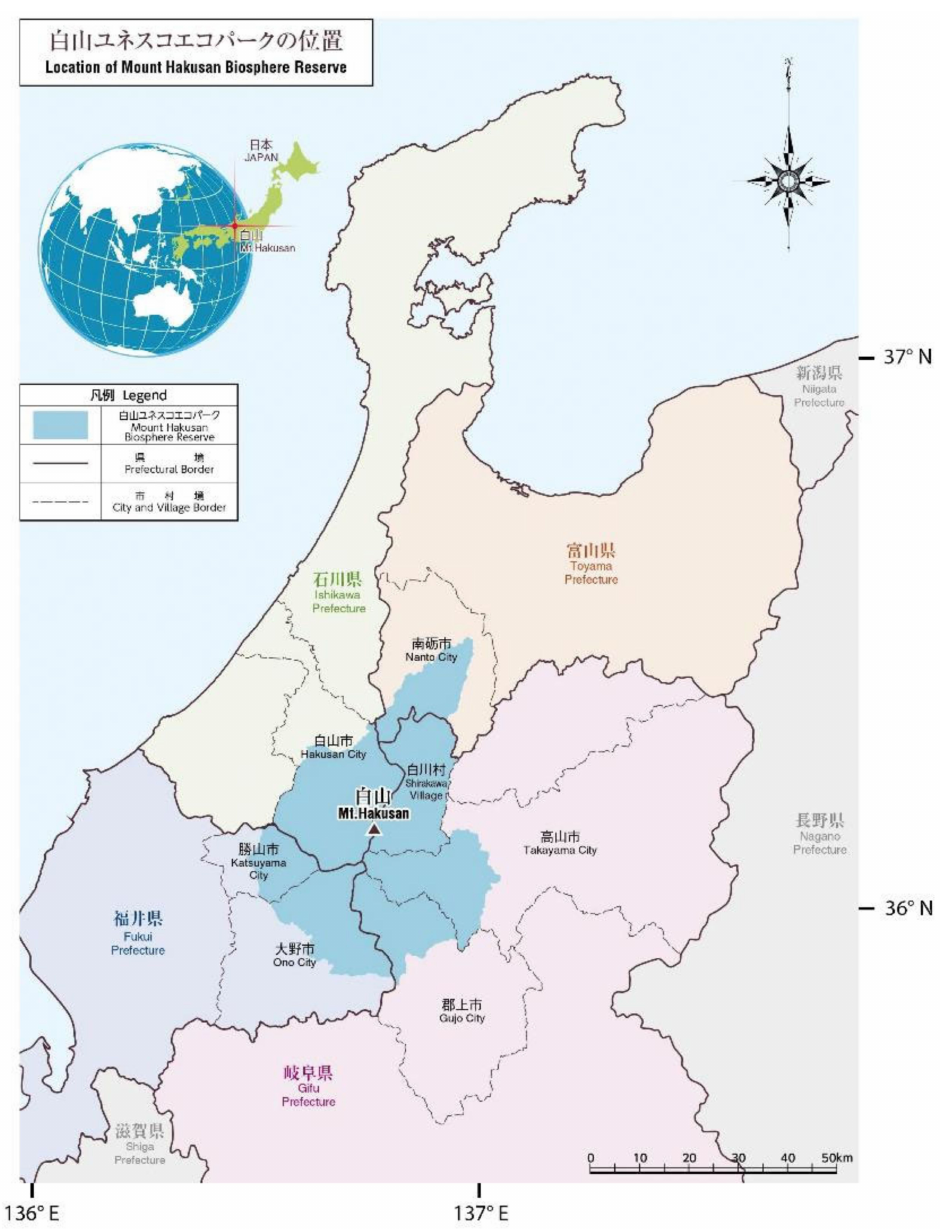
Figure 1. Location of the Mount Hakusan Biosphere Reserve between four